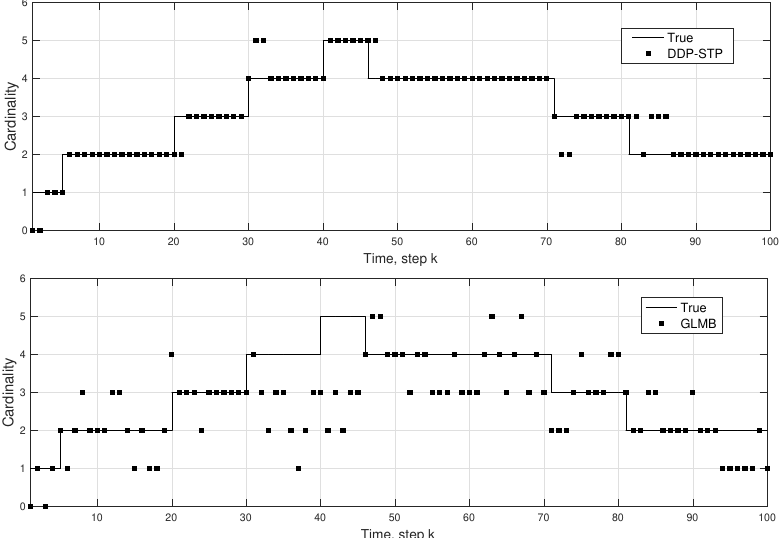
Figure 6. True and estimated cardinality using ( a ) DDP-STP and ( b ) GLMB in Experiment 2.